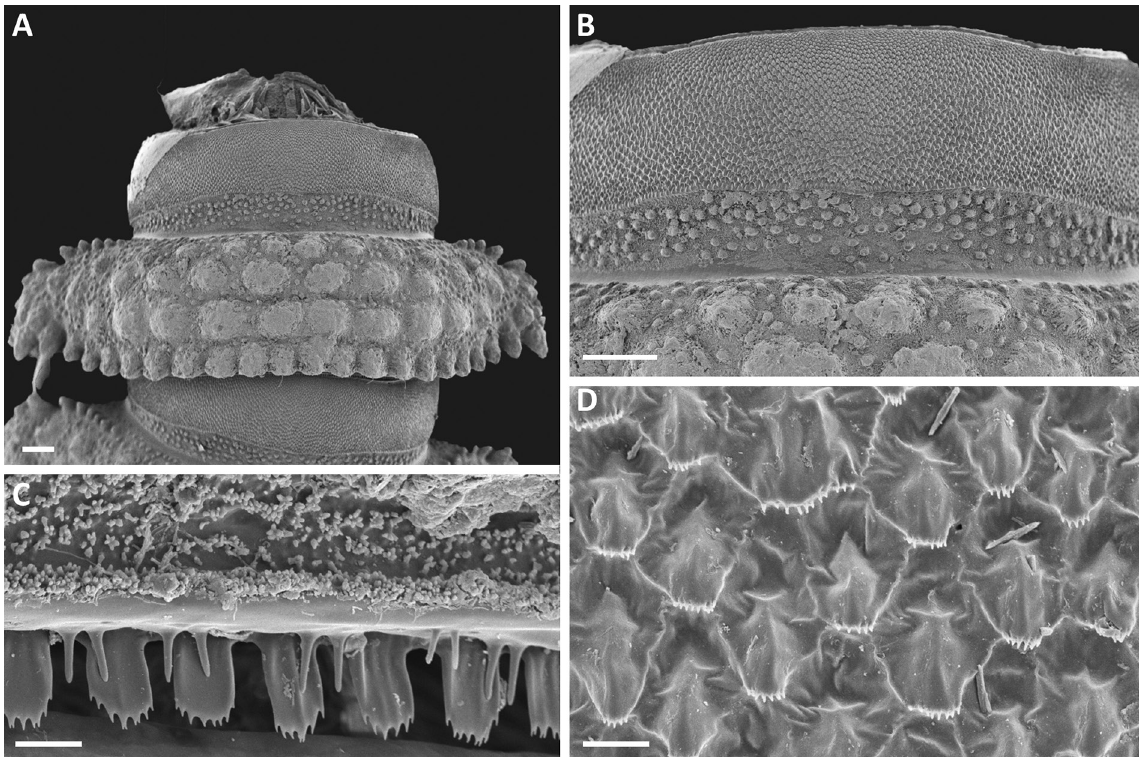
Fig. 18. Thelydesmus dispar Cook, 1896, ♀ (NHMD 621849) from Côte d’Ivoire, 12 km S of Lakota, 1965, V. Schiøtz leg. A . Ring 8, dorsal view. B . Ring 8, median part of prozona and anterior part of metazona. C . Ring 10, limbus. D . Ring 8, part of anterior ⅔ of prozona. Scale bars: A–B = 0.2 mm; C–D = 0.01